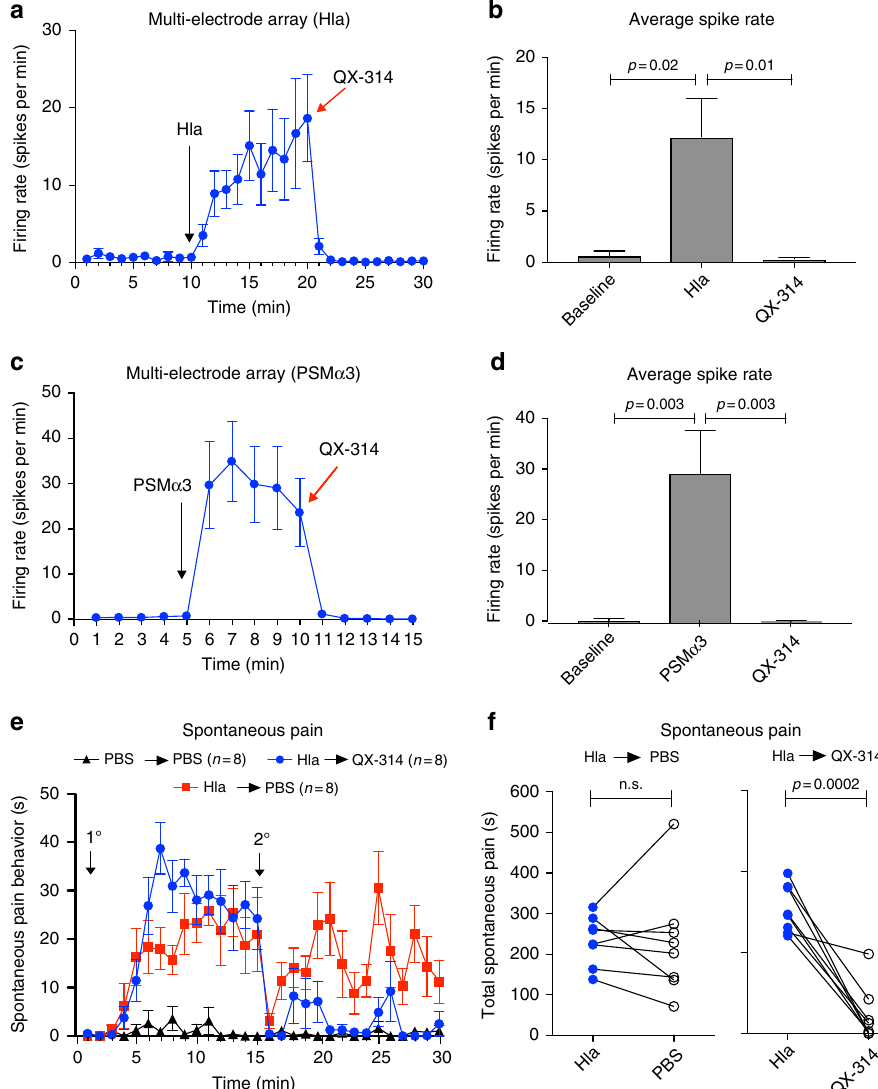
Fig. 6 QX-314 blocks PFT induced DRG neuronal fi ring in vitro and spontaneous pain in vivo. a , c DRG neuronal fi ring measurement on multi-electrode array (MEA) plates after sequential applications of Hla (30 μ g/ml or 1 μ M) at 10 min and 5 mM QX-314 at 20 min ( a ) or PSM α 3 (270 μ g/ml or 10 μ M) at 5 min and 5 mM QX-314 at 10 min ( c ). Arrows indicate time of Hla, PSM α 3, and QX-314 applications; n = 20 electrodes over six plates ( a ) and n = 46 electrodes over three plates ( c ). b , d Average spike rate calculated over 5 min at baseline and after applications of the toxin (Hla ( b ) and PSM α 3 ( d )) and after application of QX-314, statistical comparisons by repeated measures (RM) one-way ANOVA with Tukey ’ s post-tests. e Spontaneous pain was measured in 1-min time intervals after injection of either Hla (1 μ g or 1.7 μ M) or PBS into the hind paw. At the 15-min time point, mice were then injected with either 2% QX-314 or PBS (arrows indicate times of injection of each item; n = 8 mice per group). f Quanti fi cation of spontaneous pain over 30 min. Data in e shows a signi fi cant decrease in total Hla-induced spontaneous pain after QX-314 but not PBS treatment. a – f N = 3 replicates. p values, paired t tests. n = 8 mice per group. Error bars throughout fi gure, mean ±